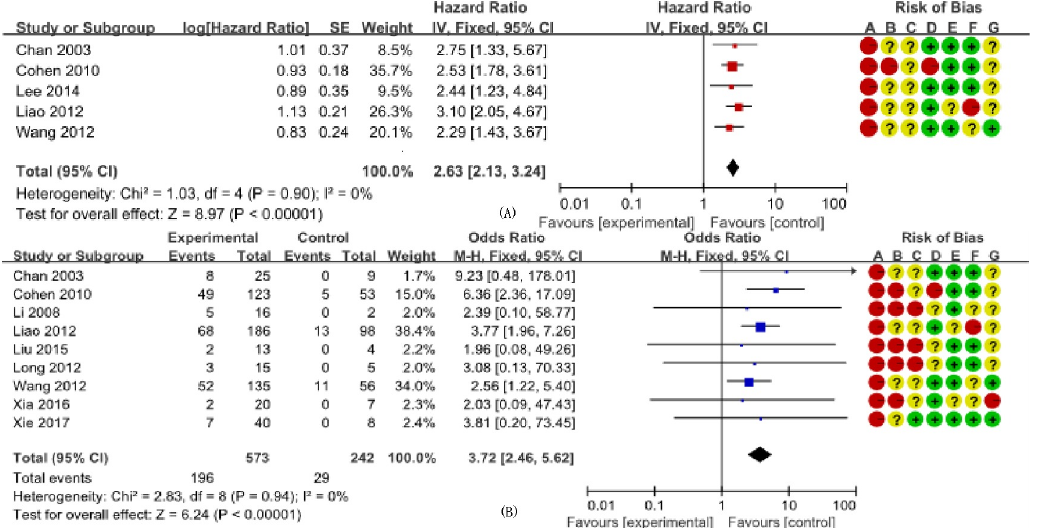
Fig 2. FIGO (International Federation of Gynecology and Obstetrics) staging. Forest plot of FIGO staging (Ia-IIa/IIb-IV) and overall survival of small cell carcinoma of the cervix patients. (A) The hazard ratios of the analyzed studies; and (B) the odds ratios of the analyzed studies. SE: standard error; CI: confidence interval.